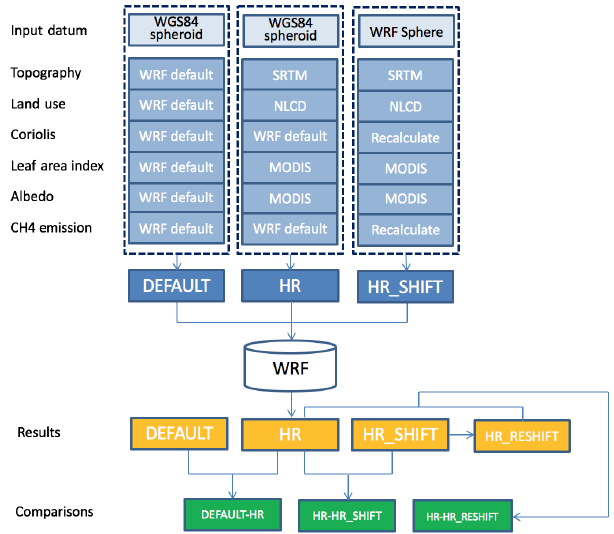
Figure 5. Workflow of the study showing the three scenarios: DE- FAULT, HR and